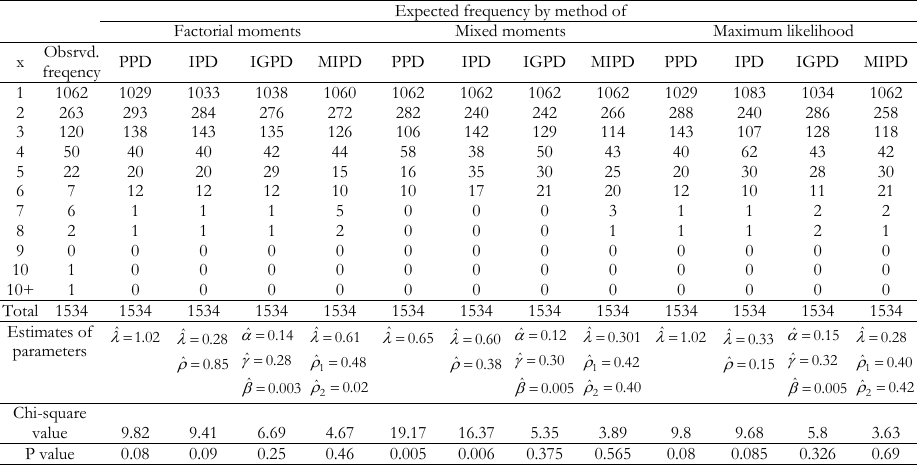
Comparison of fit of MIPD using various methods of estimation for the second data set Expected frequency by method of Factorial moments Mixed moments Maximum